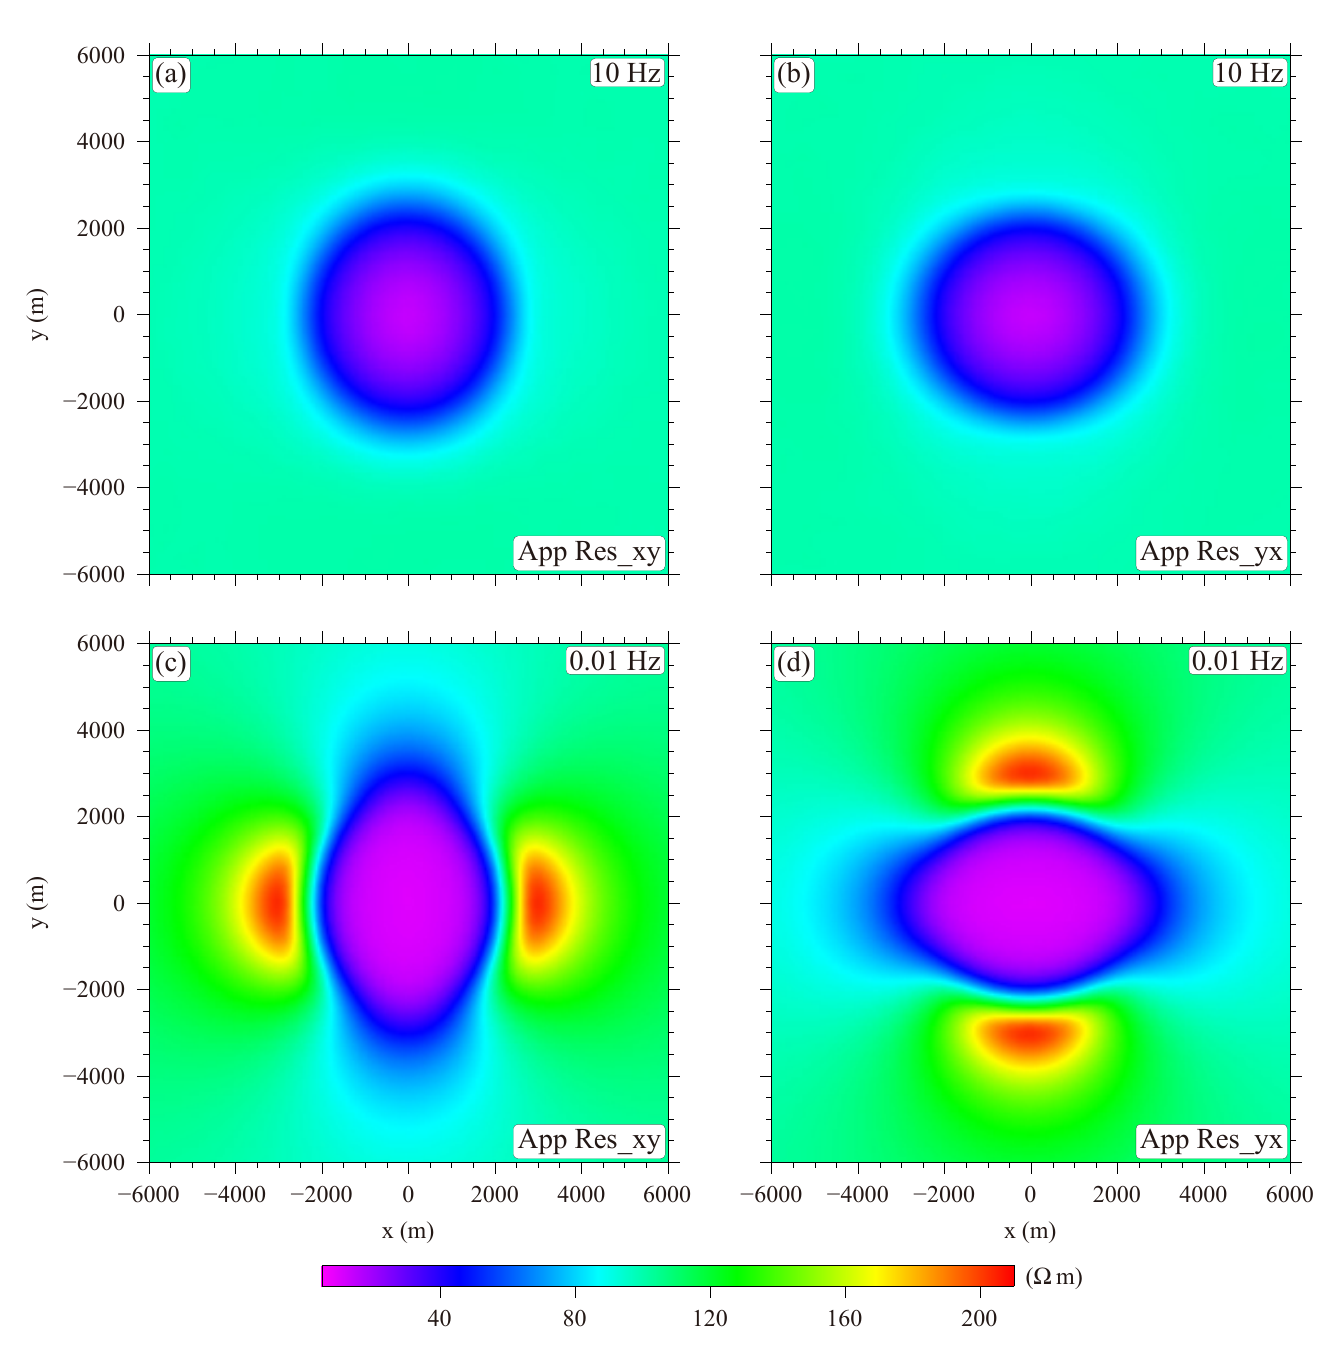
Figure 7. The contour maps of the apparent resistivities for Model 1 of the typical hydrothermal system, as shown in Figure 5. ( a , b ) are for 10 Hz, ( c , d ) are for 0.01 Hz.